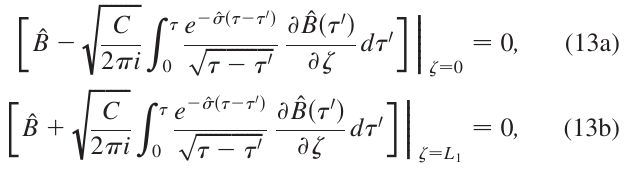
is the power of diffraction losses associated with the cutoff mode B . Useful power is proportional to P , while the þ other terms in (17) represent various channels of energy losses. Simulation of the FEL operation is carried out for the lengths of the input and output Bragg reflectors l 1 ¼ 34 cm , l 17 cm separated by the regular section of 2 ¼ length l 0 ¼ 70 cm , for the resonator made of copper (cid:4) (cid:1) 0 : 2 (cid:9) m . For the electron energy 5 MeV and undulator period 6 cm, the radiation frequency is f ¼ 1 THz . For the sheet beam current density 10 A = cm , the gap between ¼ plates a 0 ¼ 6 mm and undulator field amplitude H u 5 kOe , one can obtain for the gain parameter C (cid:1) 1 : 4 (cid:7) 10 (cid:3) 4 . Normalized section lengths are L 1 , L 2 , 1 ¼ 0 ¼ L 2 ¼ 0 : 5 and the coupling coefficients are ^ (cid:2) 1 ¼ 1 : 1 , ^ (cid:2) 2 ¼ 0 : 8 . Results of the simulation are presented in Figs. 4–6. In Fig. 4 the process of establishment of steady-state oscil- lations is demonstrated. The longitudinal profile of partial waves in the steady-state regime in Fig. 5 shows that the main amplification of the synchronous wave A takes þ place after the upstream mirror. As a result, the amplitude of the cutoff mode B excited in the advanced Bragg struc- ture is relatively small. Correspondingly, Ohmic and dif- fraction losses associated with this mode are also small. Under such conditions, up to 95% of energy radiated by the electron beam is extracted with the running wave A . For þ the calculated efficiency of (cid:12) (cid:5) 3% the power density of terahertz radiation would be (cid:5) 1 : 5 MW = cm . The transient time is about 100 ns.